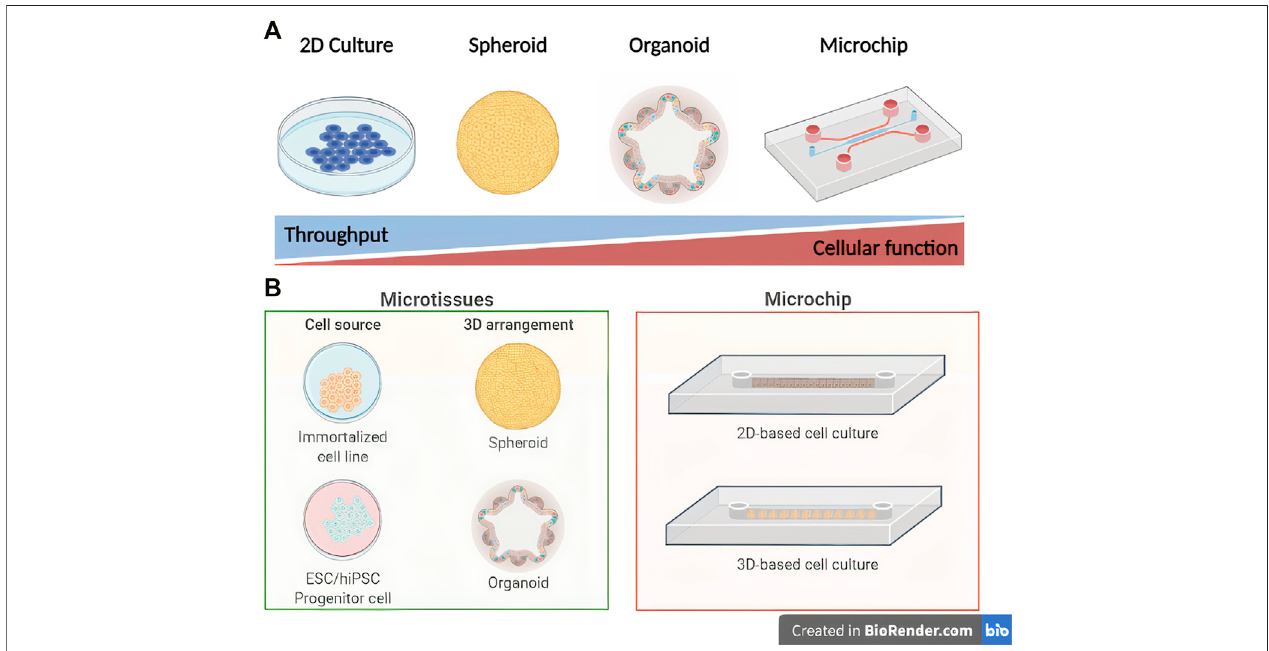
FIGURE1| Schematicrepresentationof invitro liverengineeringmodelingplatforms.Comparisonofthroughputlevelversushepatocytebiologicalfunction (A) and subdivisions of microtissue/microchip techniques (B) (Created with BioRender.com).